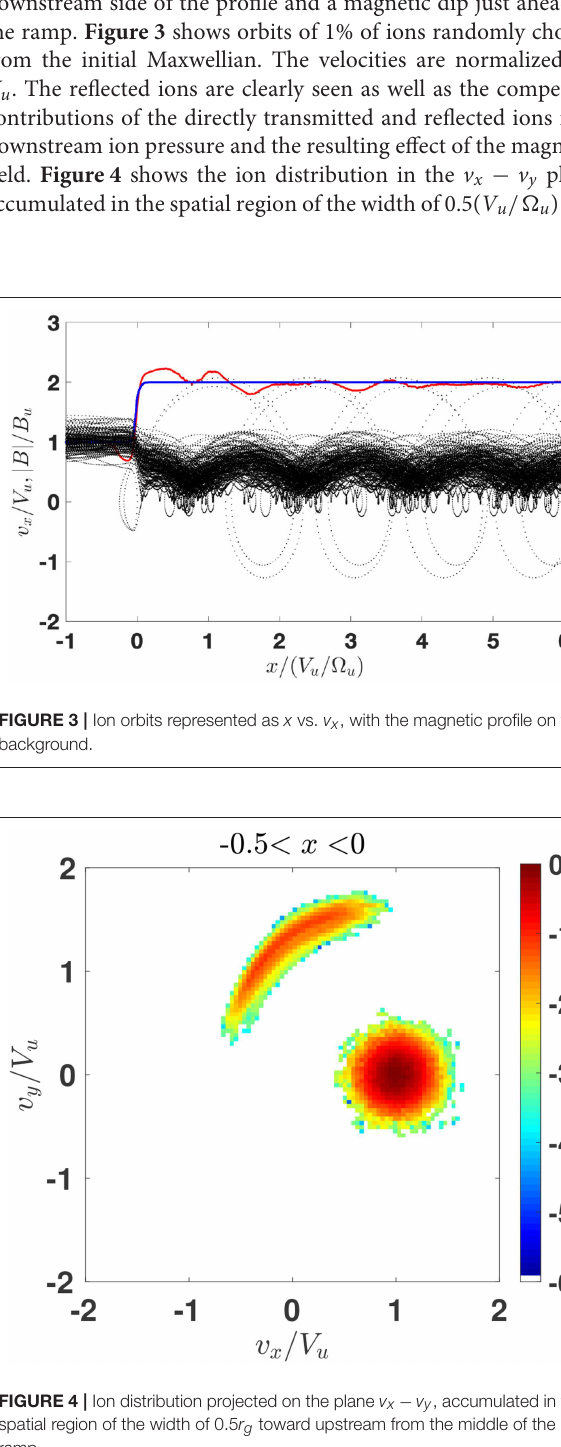
FIGURE 4 | Ion distribution projected on the plane v x spatial region of the width of 0.5 r g toward upstream from the middle of the